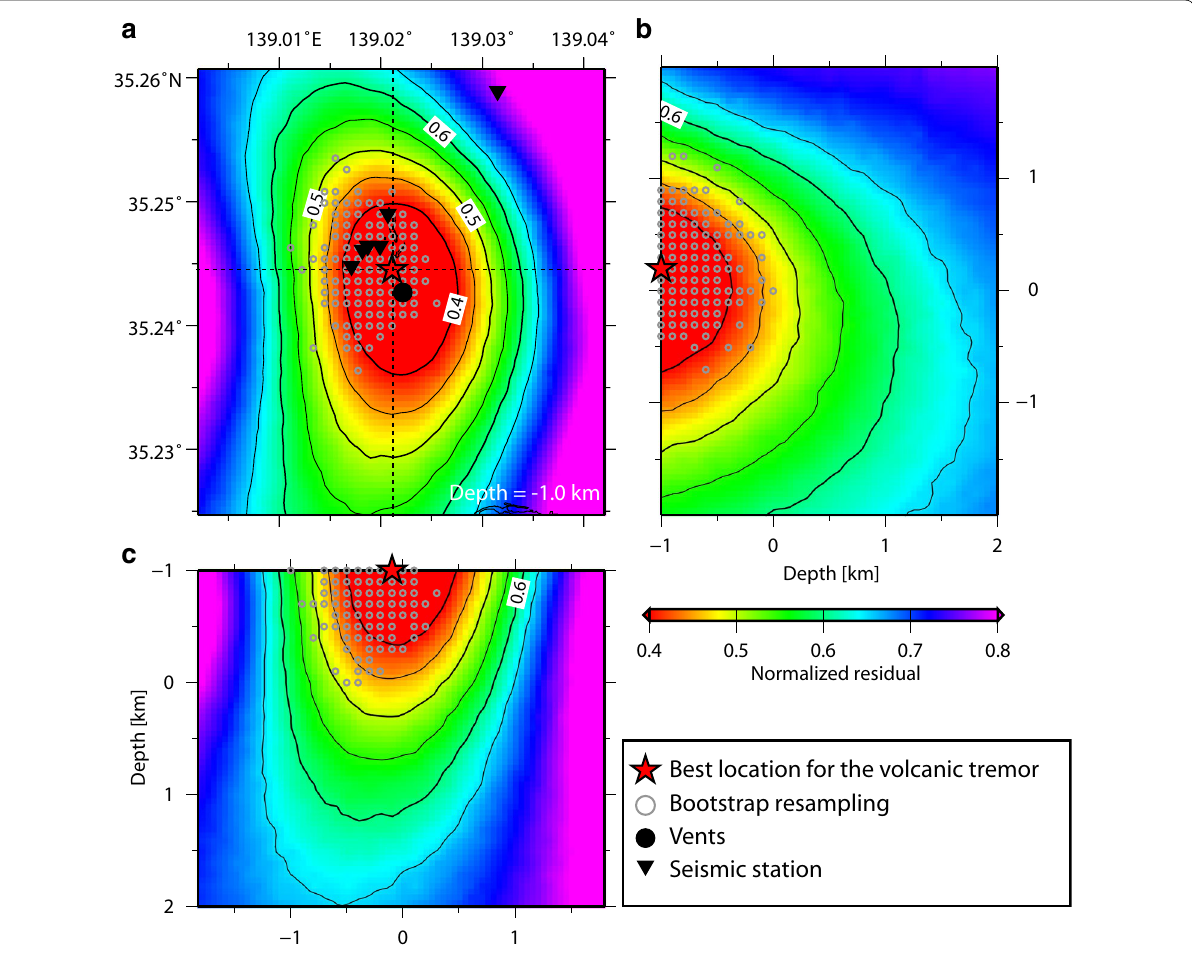
Fig. 7 Result of grid search for the volcanic tremor source in Fig. 6. a Epicenter, b N–S cross section, and c E–W cross section. The red star and gray circles indicate the best location of the tremor source and the results of the bootstrap resampling method, respectively. The colors and contour lines on each diagram show the residual normalized by the maximum value on the section passing through the location of the best